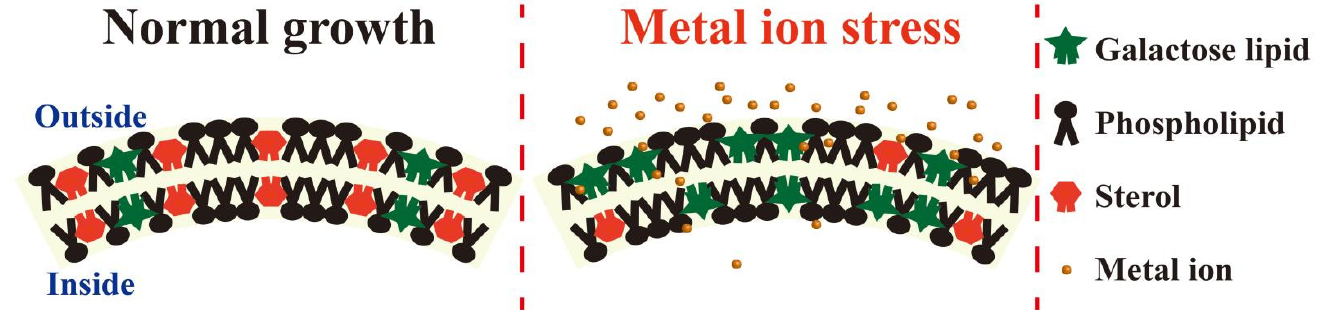
Figure 6. Changes in membrane fluidity under HMS. Plants change the adsorption of HM ions by changing the composition of membrane lipids, particularly by reducing the ratio of phospholipid sterol and contents of stigmasterol while increasing the proportion of galactose lipids. PL, phospholipid; GL, galactolipid.